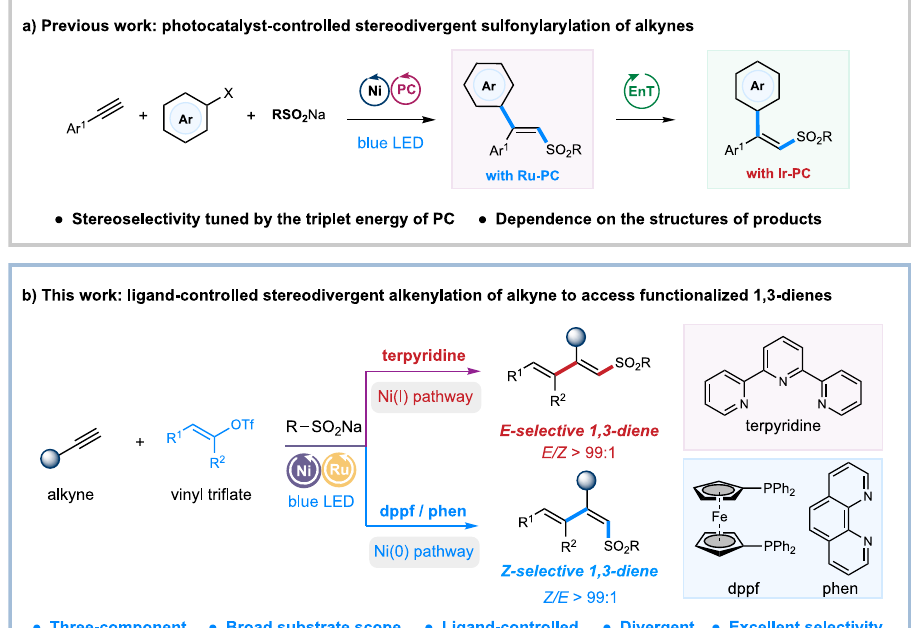
Fig. 1 | Background and recent work of carbosulfonylation of alkynes. a Previous work: photocatalyst-controlled stereodivergent sulfonylarylation of alkynes. b This work: ligand-controlled stereodivergent alkenylation of alkynes to